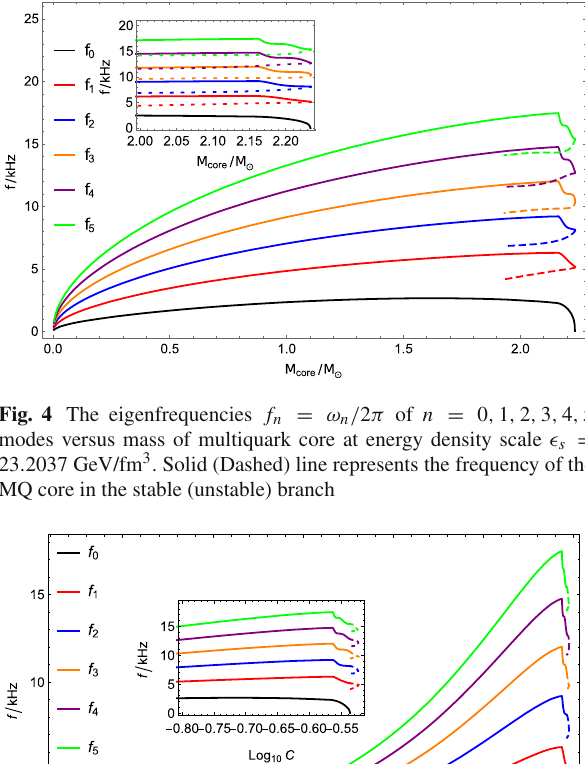
= 23 . 2037 GeV/fm 3 ), higher-mode oscillations show (cid:3) s